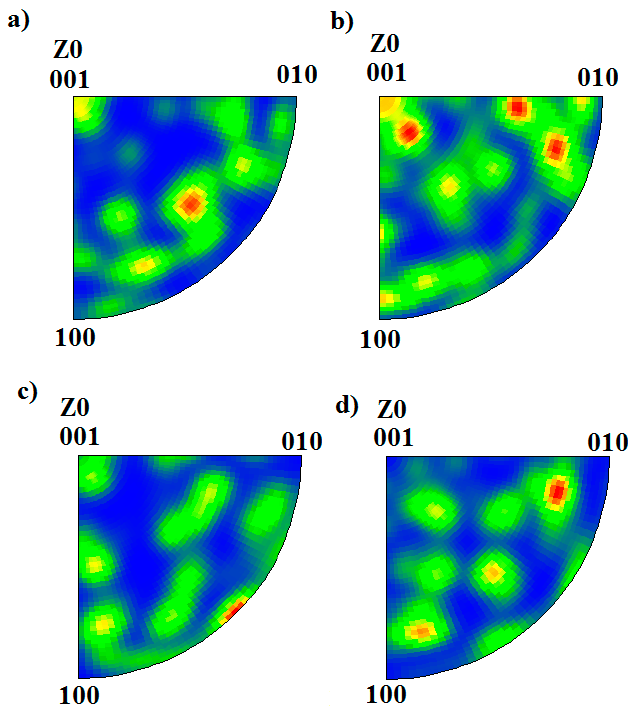
Figure 5. IPF of σ precipitating at ( a ) 990 °C, ( b ) 880 °C, ( c ) 750 °C, and ( d ) 640 °C.